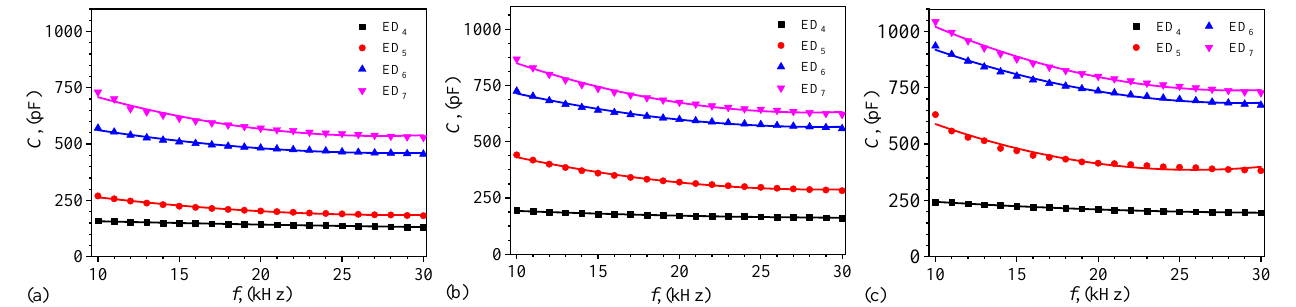
Figure 10. Variations in capacitance C with the frequency f of a sinusoidal electric field at discrete values of the magnetic flux density B . ( a ) B = 0 mT. ( b ) B = 200 mT. ( c ) B = 400 mT.